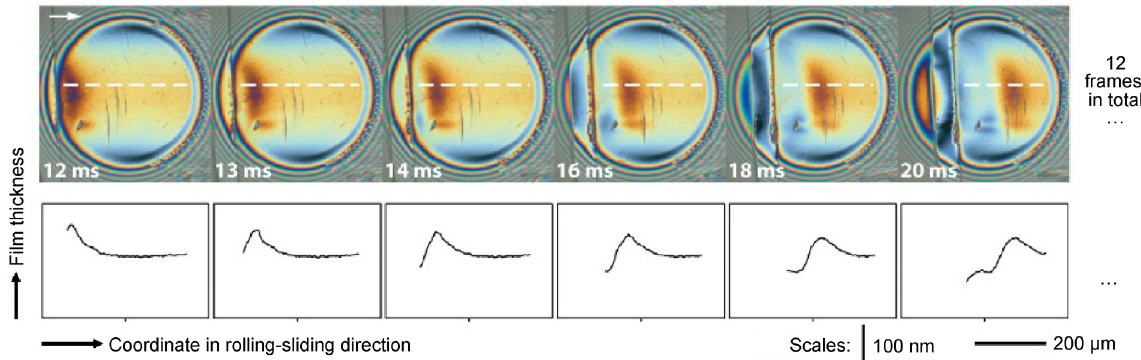
Fig. 9 Film thickness variations associated with transverse ridge under steady rolling-sliding